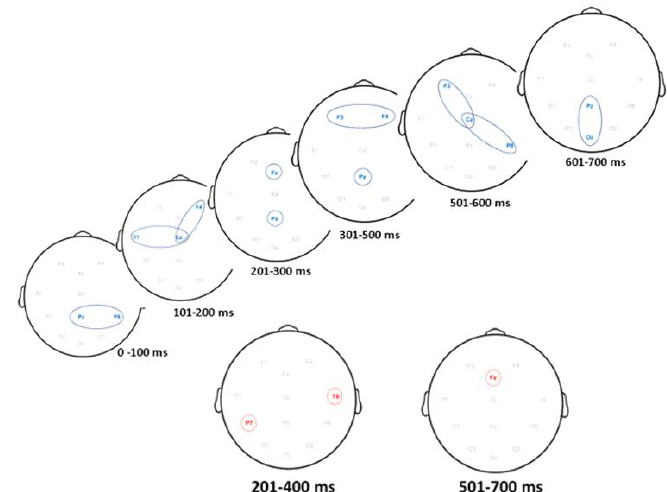
Figure 6. Neural paths of maximum ERP activity over seven interval bins of 100 ms time intervals. Top Panel: Target. Bottom Panel: Distractor.